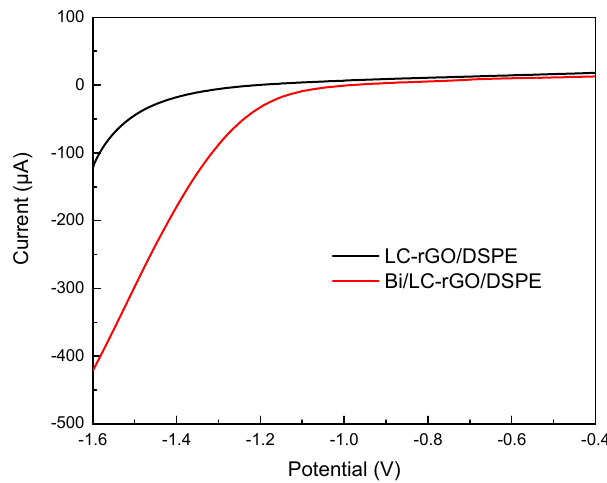
Figure 4. Linear sweep voltammetry of ( a ) the LC ‐ rGO/DSPE and ( b ) Bi/LC ‐ rGO/DSPE in 0.1mol/L acetic acid buffer solution with a scan rate of 50 mV/s (supporting electrolyte: 0.1 mol/L pH 4.5 acetate buffer solution; Bi(III) concentration: 2 mg/L).